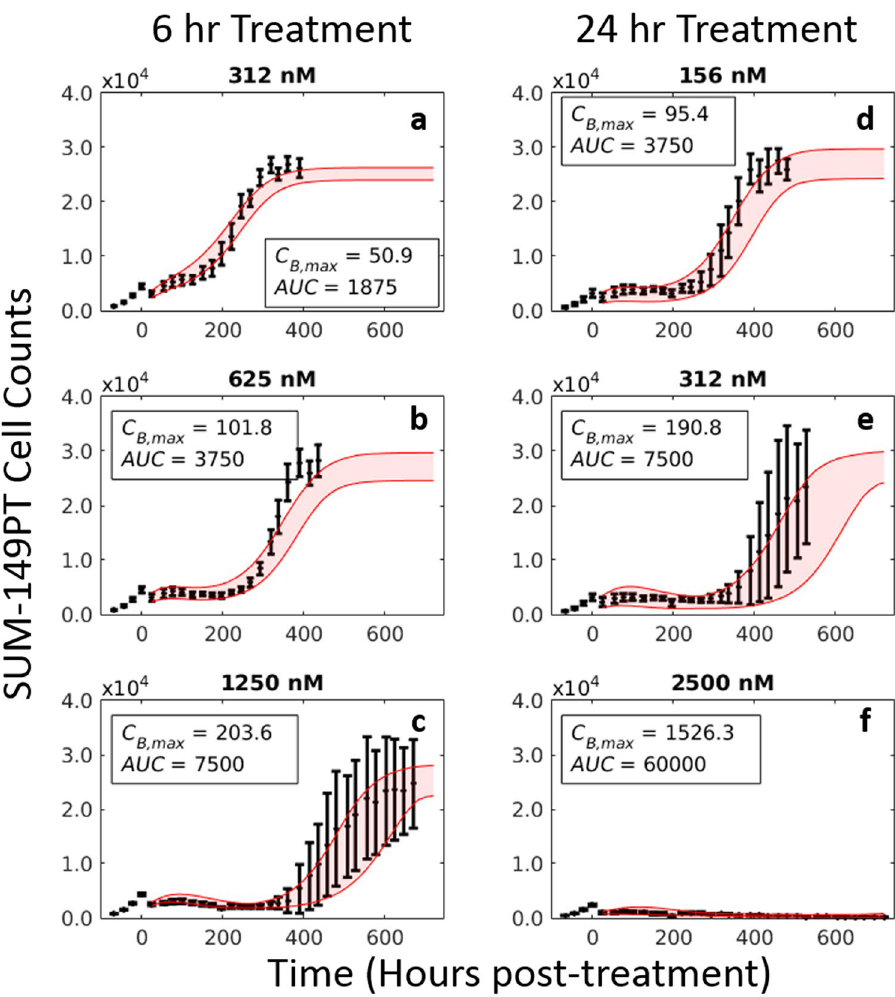
Figure 6. Model prediction results in SUM-149PT cell line. As described in Section 2.6, model parameters ( k d,A , θ in Eq. (5A) and k θ in Eq. (5B)) were fit to each treatment condition in the training set (12-hour exposure d,B , r , dataset). These parameter fits were then described by local regression models to generate model parameter estimates for treatments in the test set (6- and 24-hour exposure datasets). Final predictions represent a weighted average of Eq. (5A) and (B), and a bootstrap analysis was used to generate a 95% confidence interval for these predictions (red overlay). A series of predictions in the SUM-149PT cell line following 6- and 24- hour doxorubicin treatments at three doxorubicin concentrations are shown. Nuclear counts from these experiments are displayed in black with error bars representing the 95% CI from the six experimental replicates. Each column corresponds to an exposure time. The response of a TNBC cell line can be predicted using experimentally-derived PK and PD